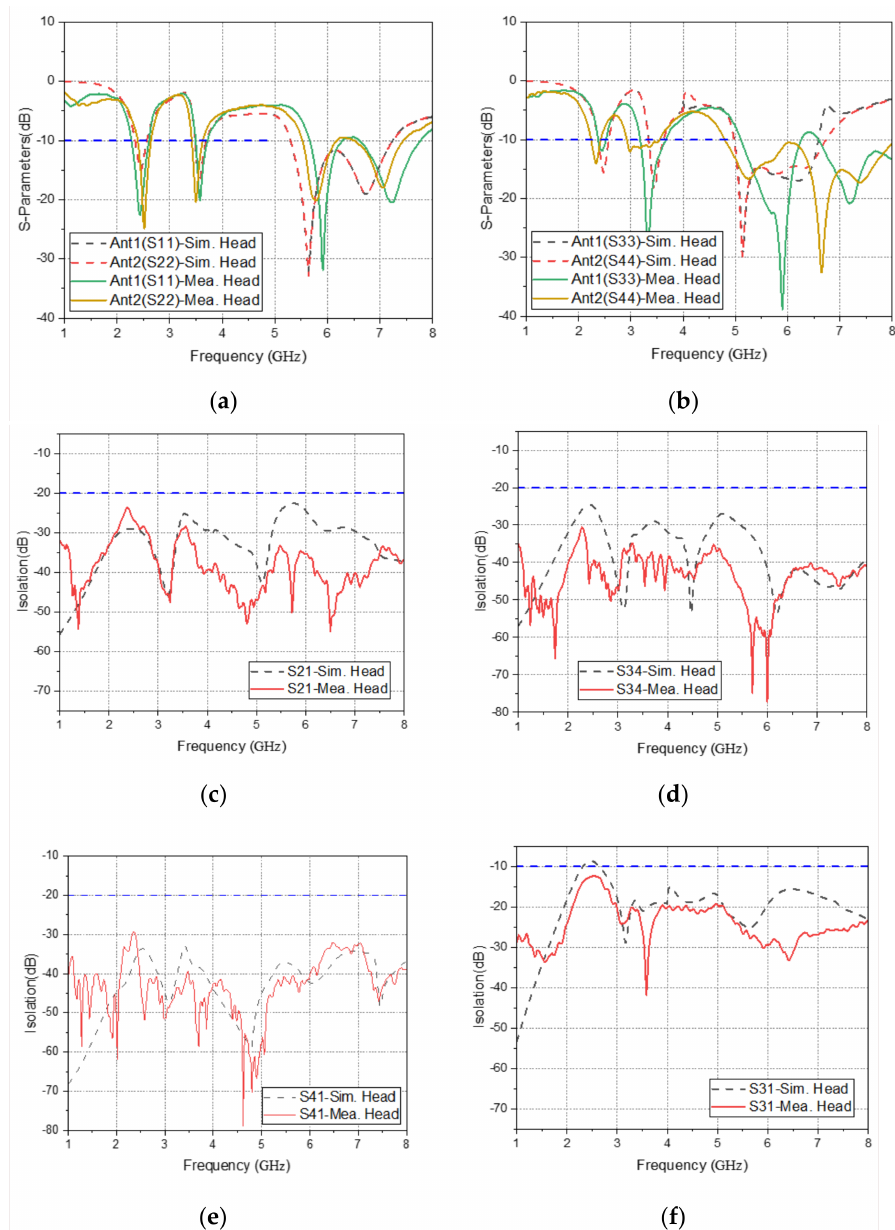
Figure 35. ( a ) Simulated and measured reflection coefficients of Ant. 1 and Ant. 2 worn on the head, ( b ) simulated and measured reflection coefficients of Ant. 3 and Ant. 4 worn on the head, ( c ) simulated and measured isolation of Ant. 1 and Ant. 2 worn on the head, the ( d ) simulated and measured isolation of Ant. 3 and Ant. 4 worn on the head, ( e ) simulated and measured isolation pf Ant. 1 and 4 worn on the head, and ( f ) the simulated and measured isolation of Ant. 1 and Ant. 3 worn on the